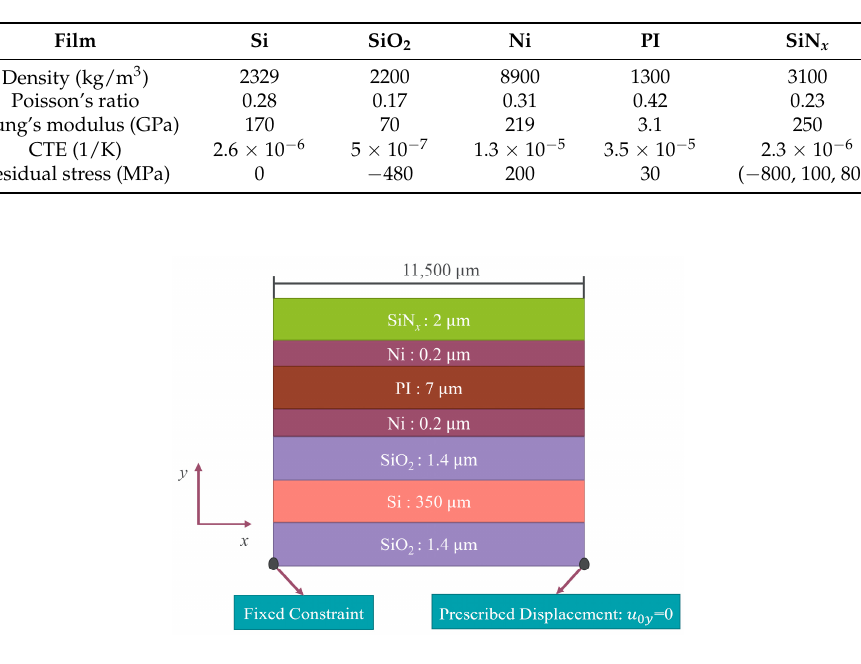
Figure 2. Two-dimensional plane stress approximation geometric model for MDBD device.